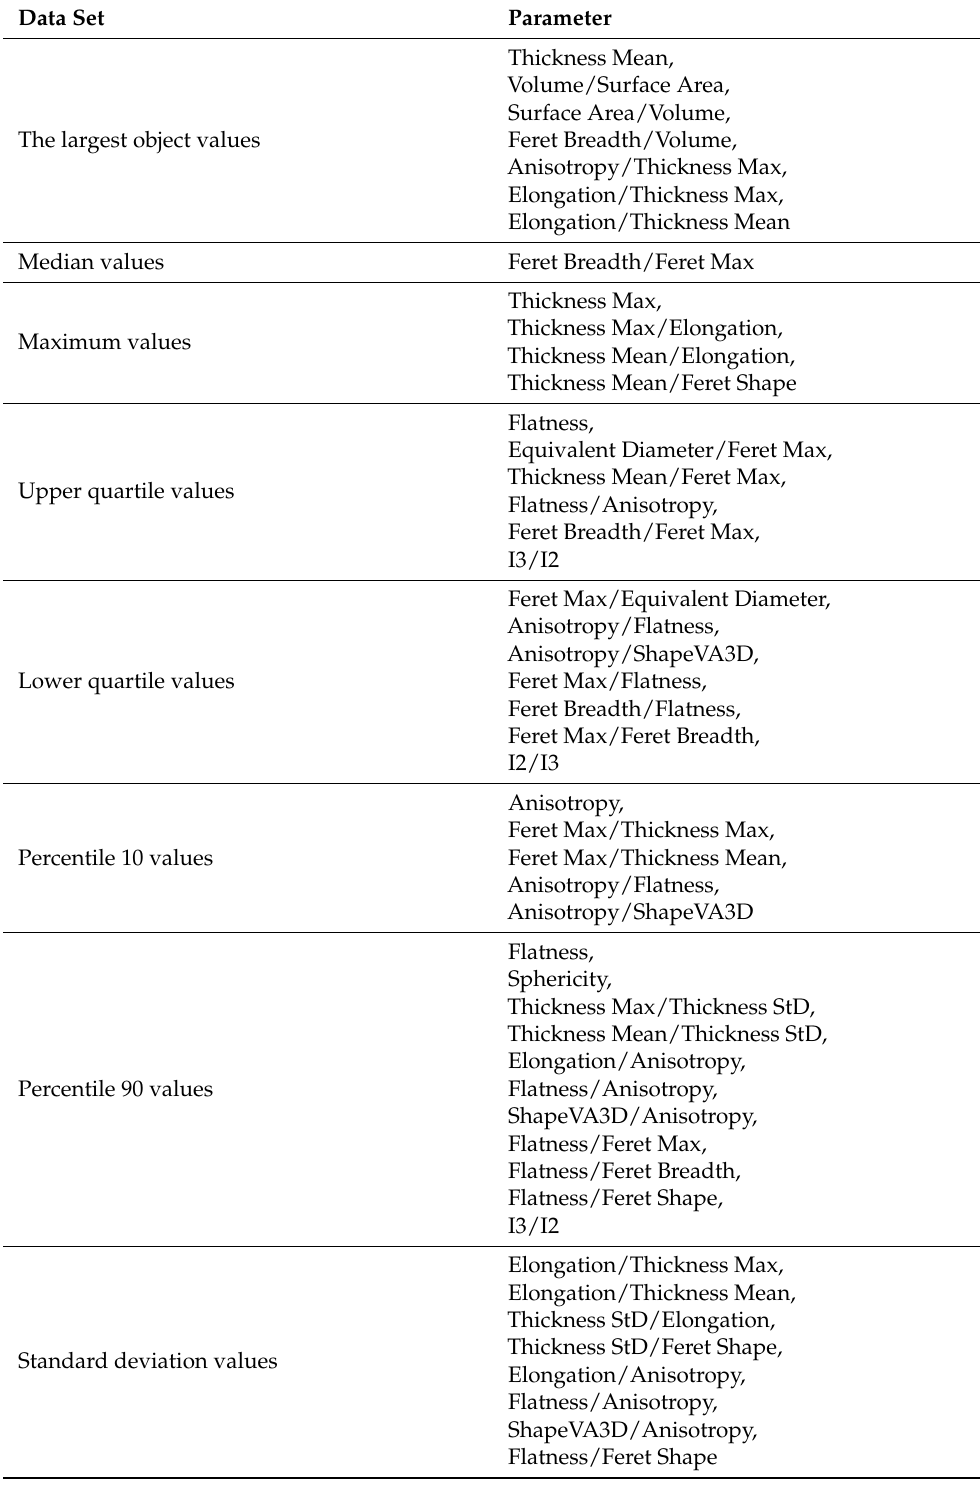
Table 2. List of parameters used in building the linear relationship with the logarithm of absolute